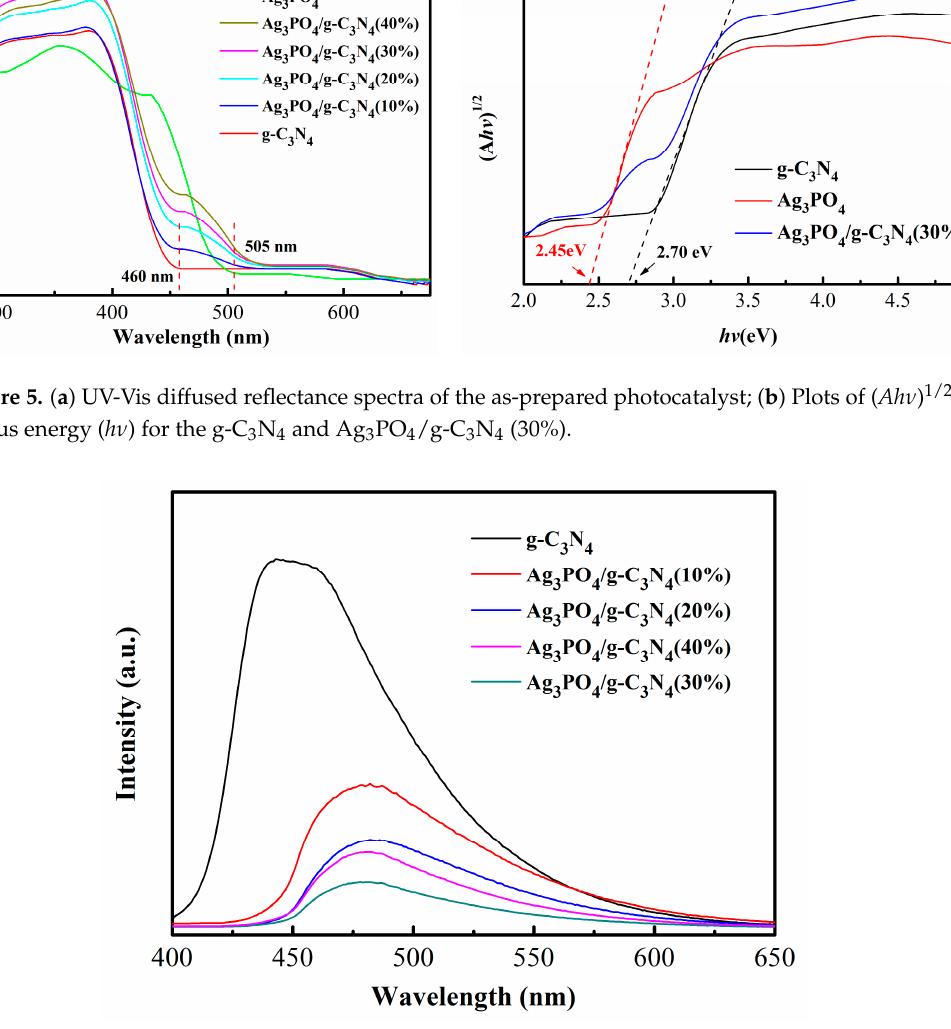
Figure 6. PL spectra of g ‐ C 3 N 4 and Ag 3 PO 4 /g ‐ C 3 N 4 (X).